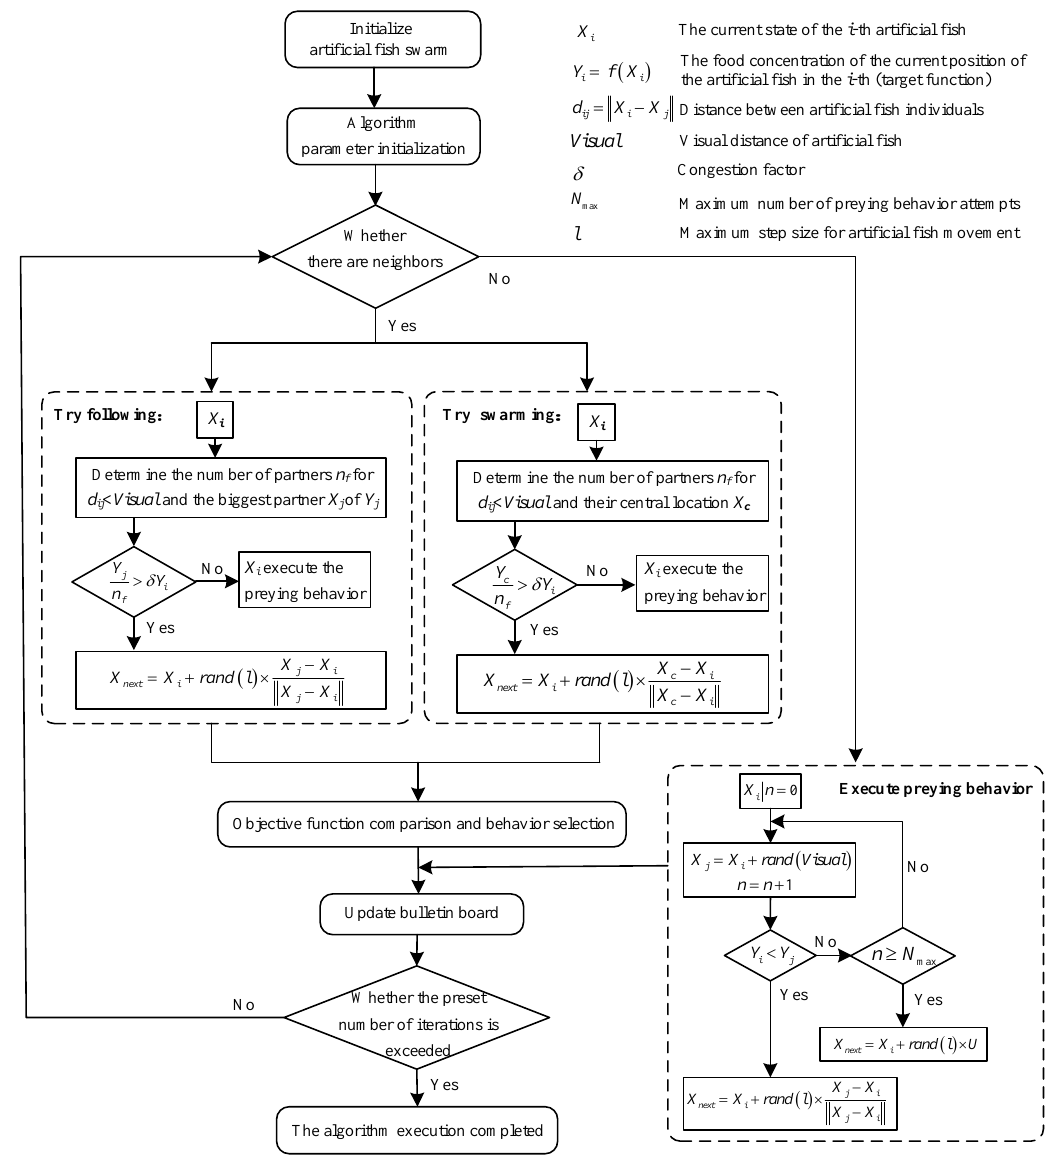
Figure 1. Flow chart of the artificial fish swarm